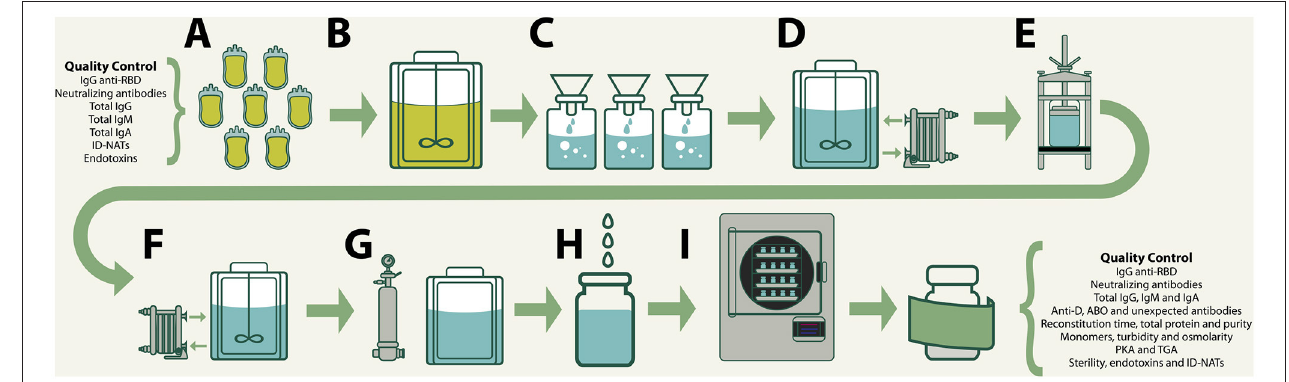
FIGURE 1 | Production of VP-IVIg and CP-IVIg by the method of caprylic acid precipitation: (A) Collection, testing and approval of raw plasma. (B) Precipitation of plasma proteins by addition of caprylic acid 5–6% (v/v). (C) Removal of precipitates by gravity filtration. (D) Diafiltration, concentration and formulation. (E) Strong anion exchanger chromatography. (F) Readjustment of the formula. (G) Sterilizing filtration. (H) Filling in type 1 borosilicate vials (40 mL/vial). (I) Lyophilization.